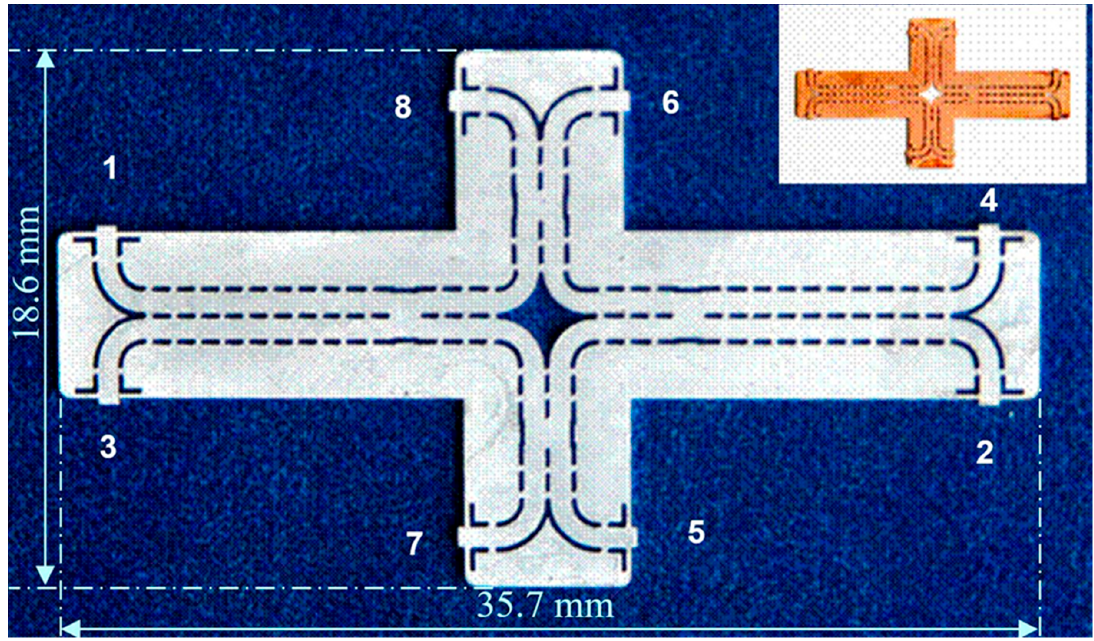
Figure 5. The layout of a substrate integrated wave-guide (SIW) multi-port fabricated in 10 mils ceramic.